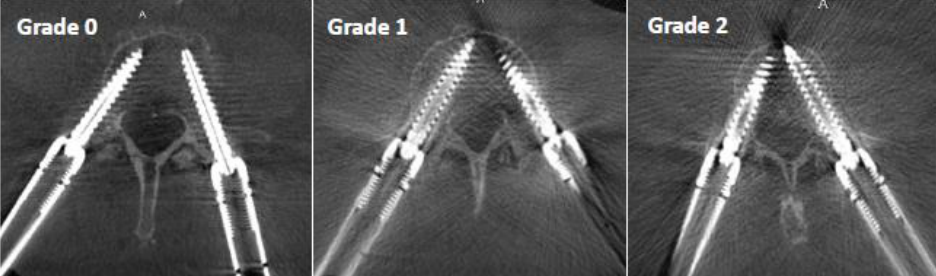
Figure 4. Pedicle screw metal artifact quality scale: Grade 0 represents a clearcut image of the screw and bony structures, Grade 1 allows assessment of the screw position with some limitations due to artifacts, and Grade 2 has a strong artifact which represents a limitation for the assessment of the exact screw position.